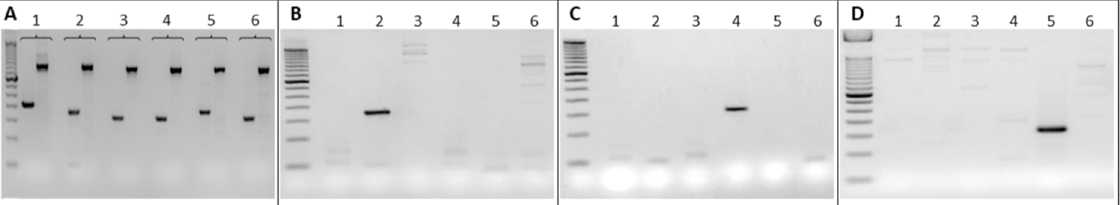
Figure 2. Specificity of BCs. Examples of gel electrophoresis showing the specificity and the absence of cross-reaction following BC amplification by PCR with the specific primers. ( A ) Example of BCs amplified with the common TBB/SpeB primers (specific band around 150 bp) and the TB/BB primers (550 bp). ( B – D ): examples of the specificity of the designed primers. Six genomic DNAs (1 to 6) were amplified with primers 2, 4 and 5 respectively. The figure shows that primer 2 amplifies only DNA 2 ( B ); primer 4, amplifies only DNA 4 ( C ) and primer 5, amplifies only DNA 5 ( D ), consistent with the absence of cross-reaction.